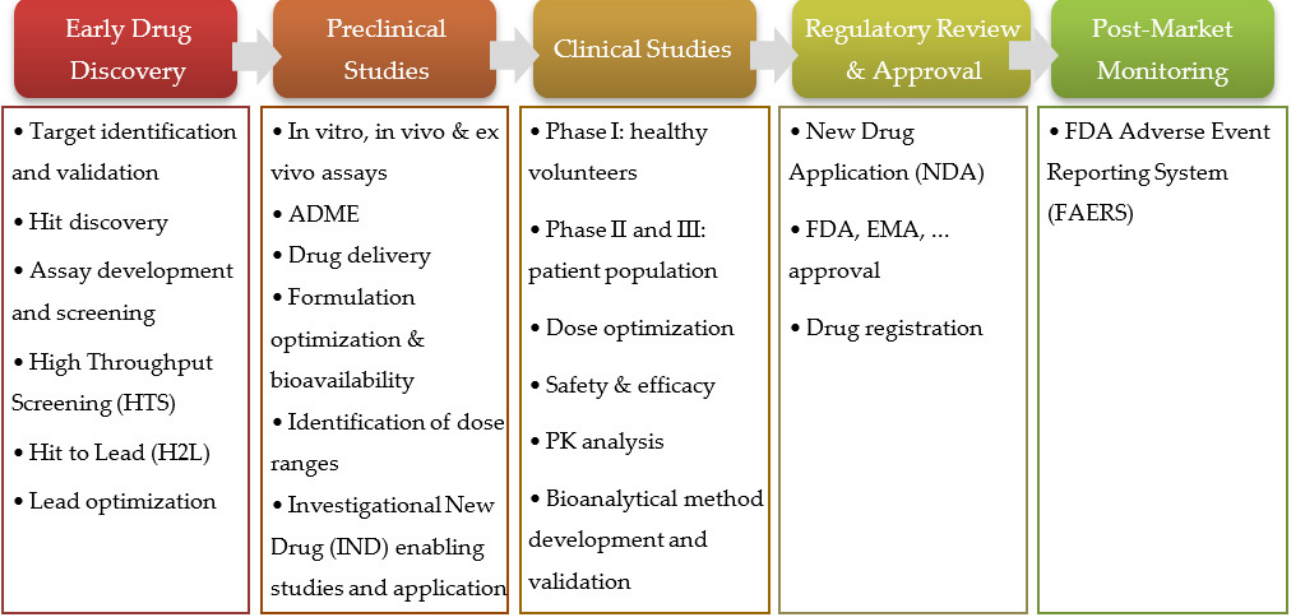
Figure 3. Outline and summary of the stages of new drugs’ R&D.